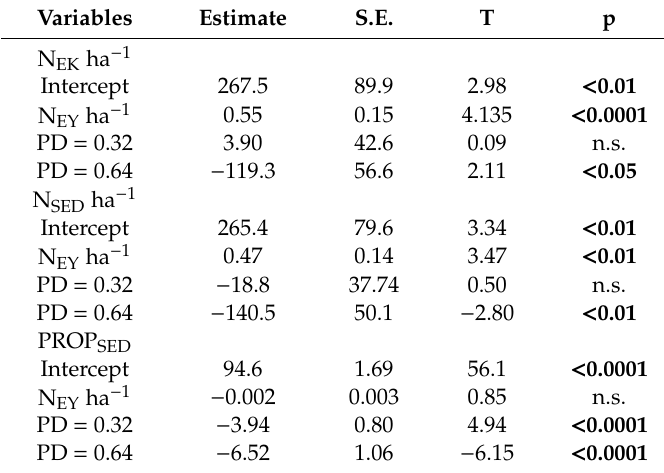
Table 2. Results of linear modelling of EK15 based total density (N EK ha − 1 ), density of single fish detection (N SED ha − 1 ) and the proportion of single fish density (PROP SED ) explained by the estimated total density by means of Simrad EY-M (N EY ha − 1 ) and ping duration (PD); S.E.: standard error, T: t-test value, p: probability of null-hypothesis to be